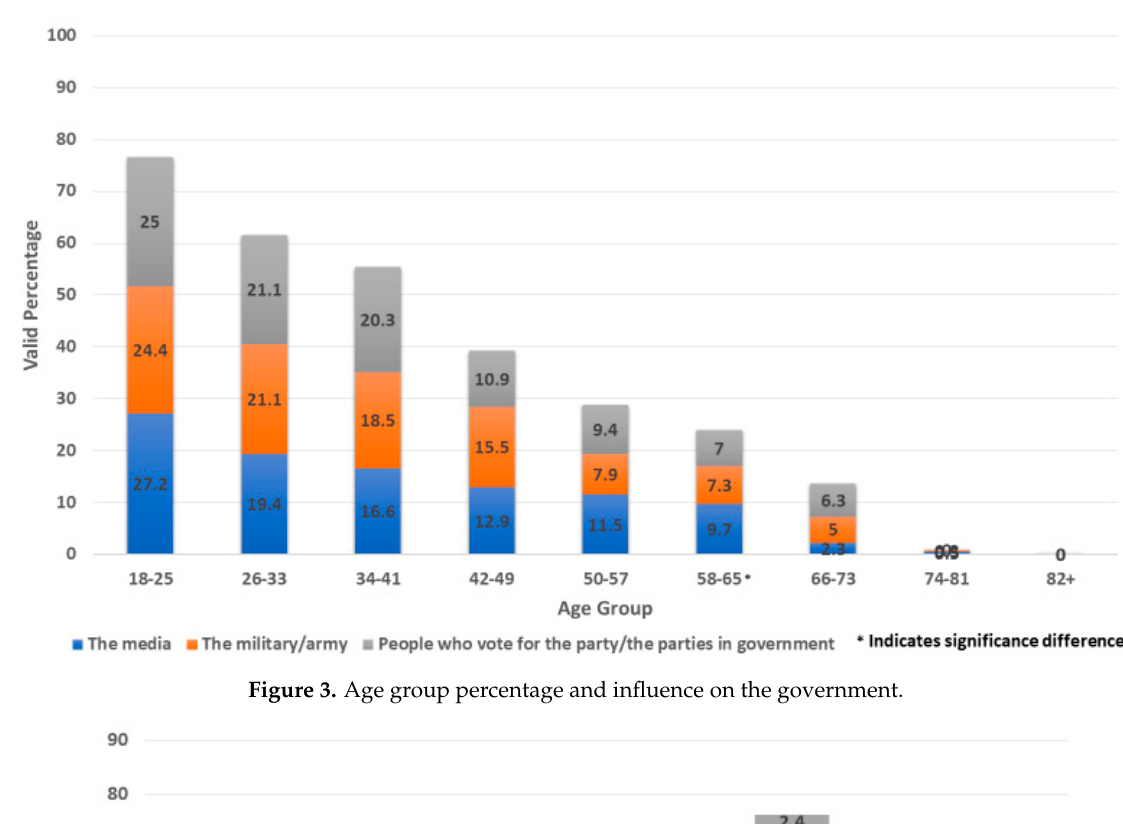
Figure 3. Age group percentage and influence on the government.